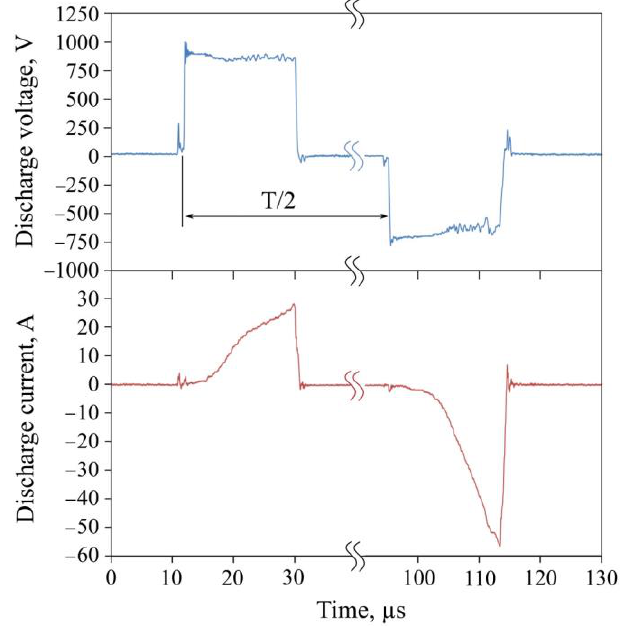
Figure 2. Oscilloscope patterns of the current and voltage waveforms of magnetrons with Ti and Al cathodes in the sputtering of the TiAlN coating.